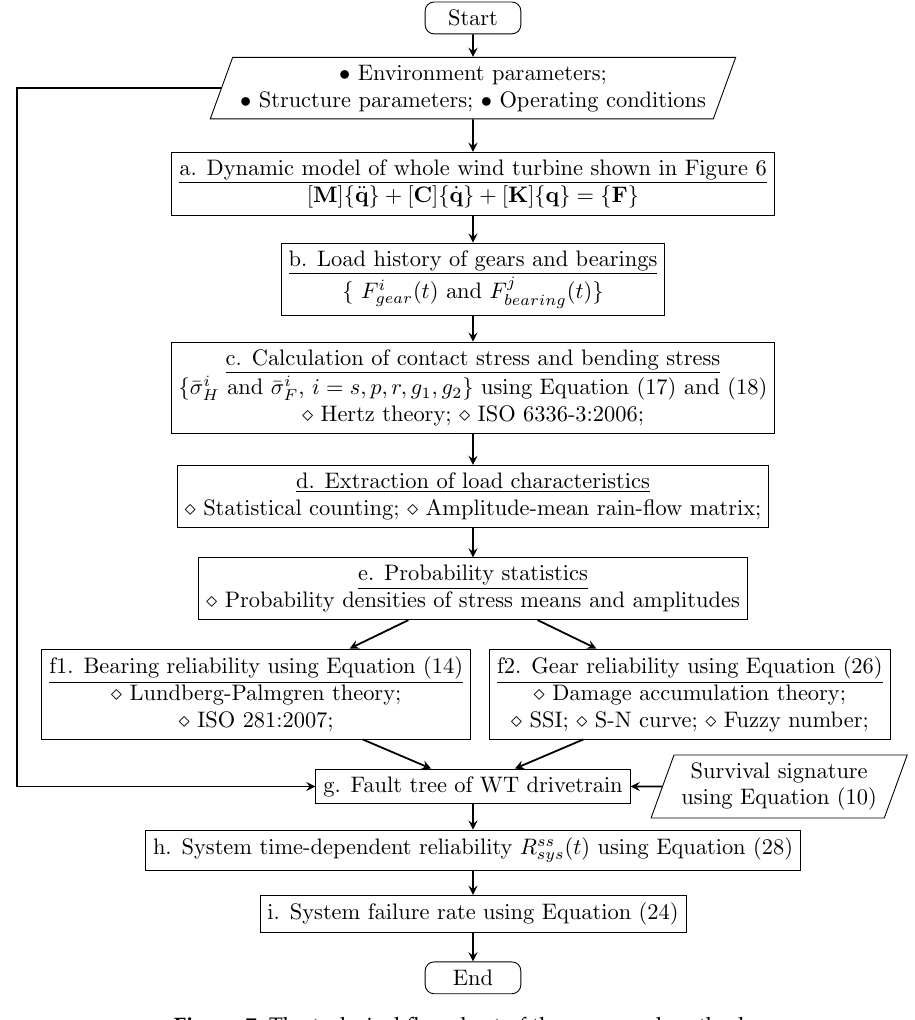
Figure 7. The technical flowchart of the proposed